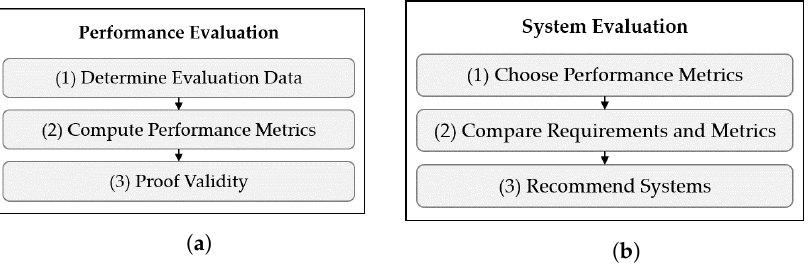
Figure 9. Functions of the module Performance Evaluation ( a ) and System Evaluation ( b